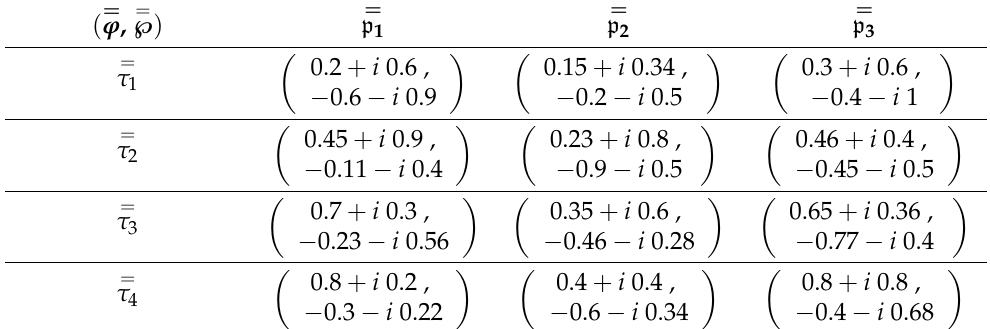
Table 3. The tabular representation of BCFSS in scenario